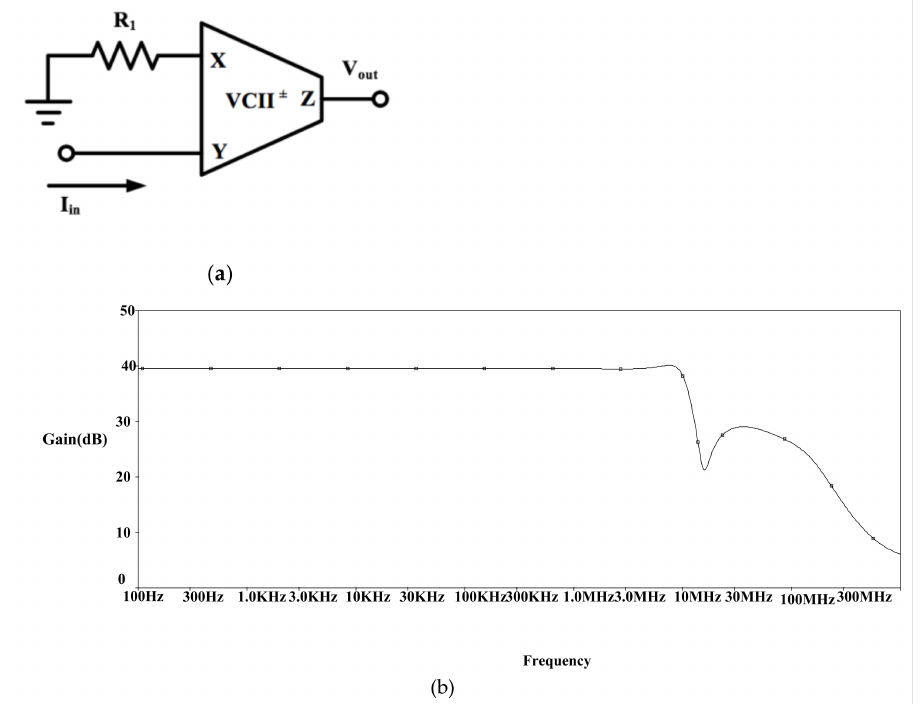
Figure 14. Application of VCII as a transimpedance amplifier: ( a ) schematic; ( b ) frequency perfor-